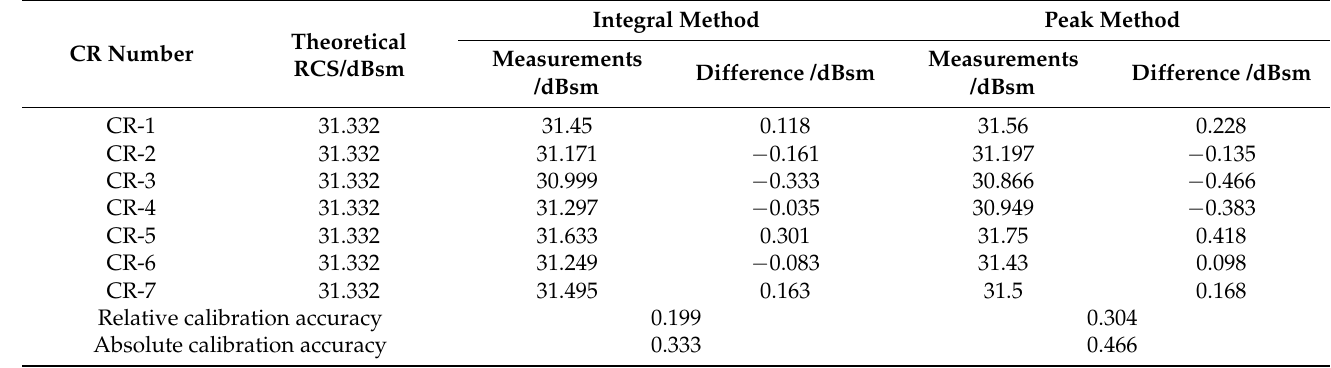
Table 9. Each point target RCS and accuracy analysis for FSI mode data on 15